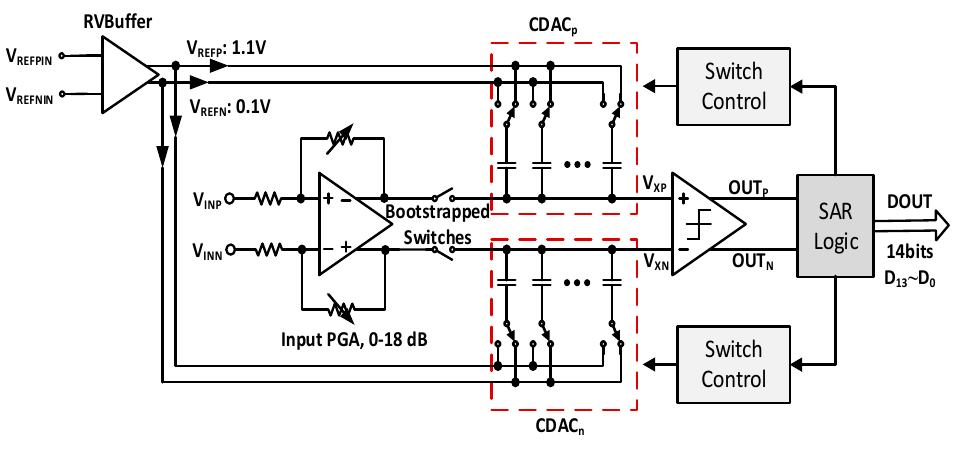
Figure 1. Overall ADC architecture.